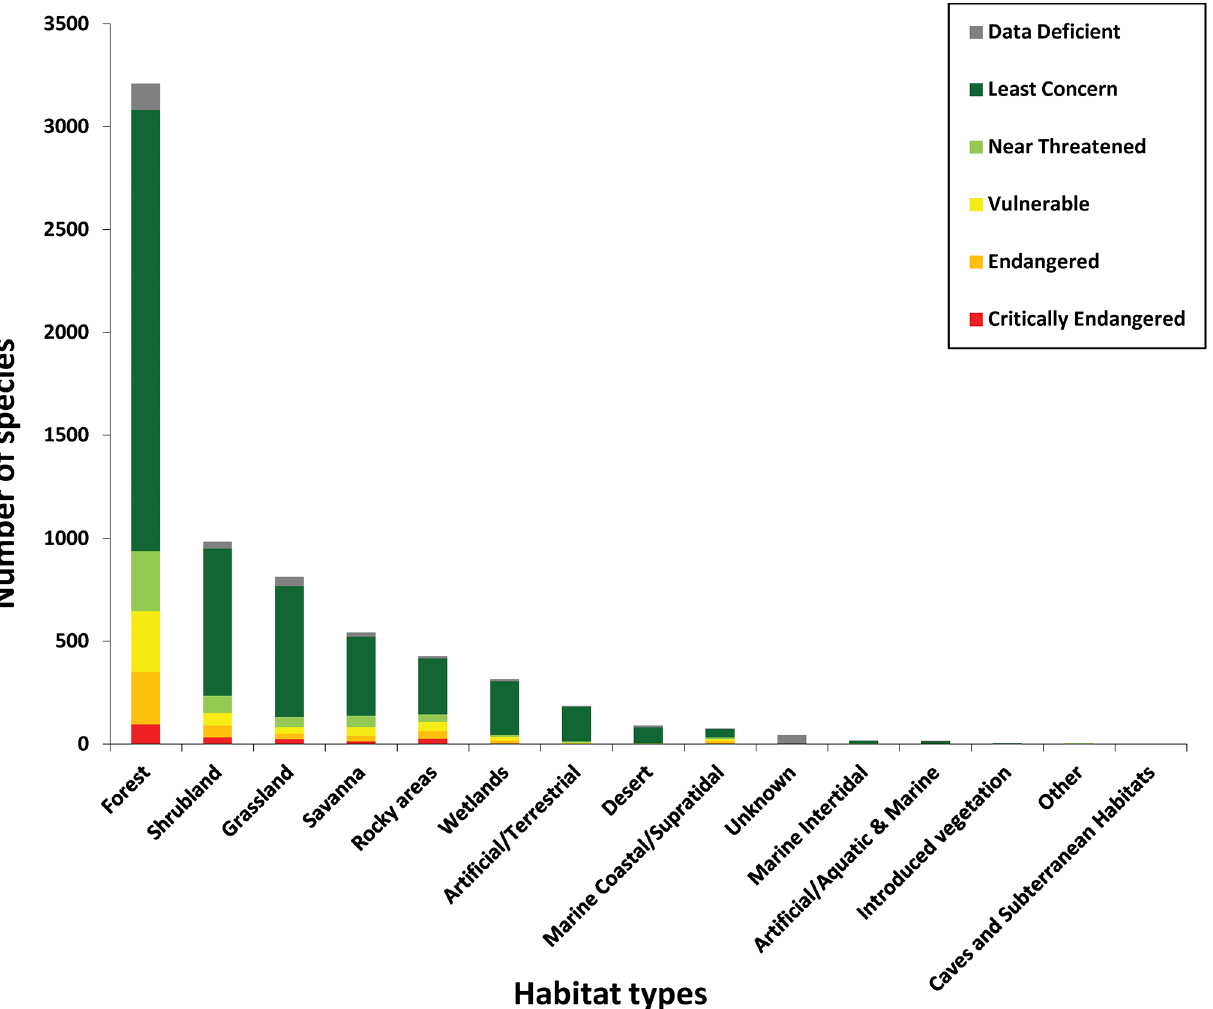
Fig 1. Numbers of species from the combined SRLI for Plants sample of gymnosperms, monocots, legumes and pteridophytes in each IUCN Red List Category by habitat.